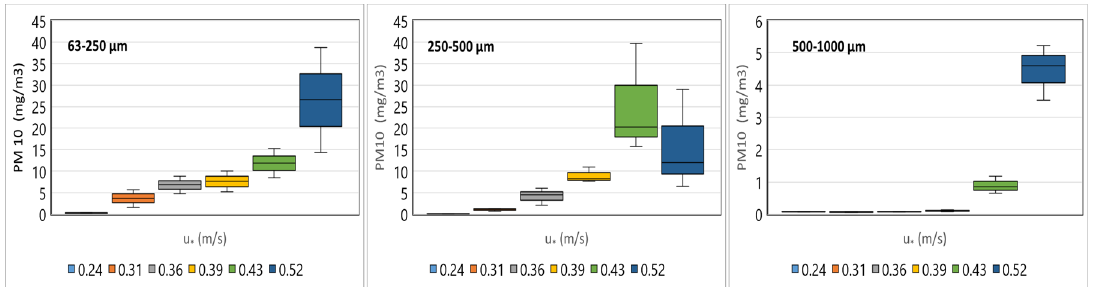
Figure 4. The particulate matter that is < 10 µm in dimeter (PM10) concentration calculated from the wind tunnel measurements of the reference samples under various shear velocities. The average concentration is presented by the solid line inside the minimum/maximum box, and standard deviations are in dashed lines. Note the differences in the value rang of Y axis.